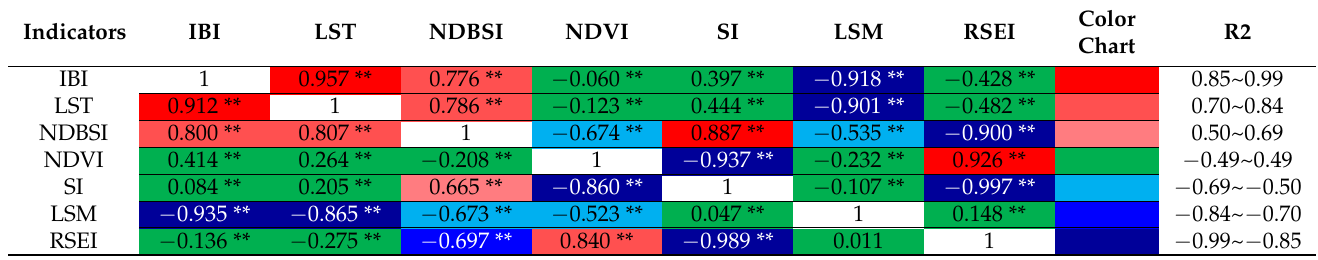
Table 3. Pearson correlation analysis (** indicates statistically significant at 0.01